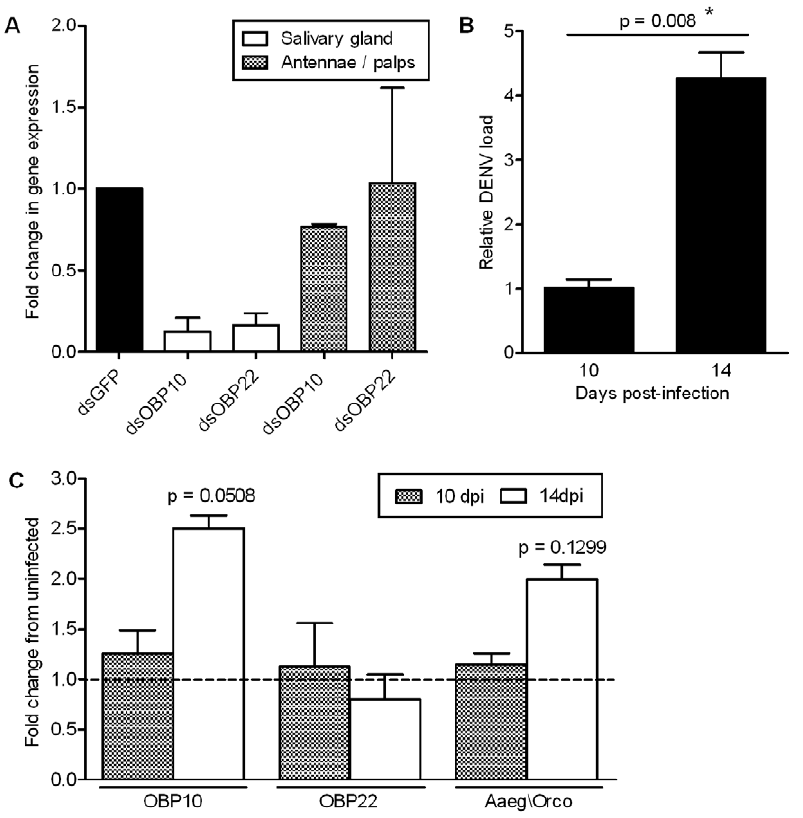
Figure 4. OBP silencing efficiency and gene expression in the chemosensory organs; detection of DENV by RT-PCR in the chemosensory organs. ( A ) Silencing efficiencies for OBPs 10 and 22 in the salivary gland and chemosensory organs (antennae and palps) 4 days post-injection of 2 ug dsRNA, relative to dsGFP-injected controls. ( B ) Detection of DENV by RT-PCR in the antennae and palps of DENV-infected mosquitoes at 10 and 14 dpbm. *, p , 0.05 in Student’s t-test. ( C ) OBP and Aaeg\Orco gene expression in the antennae and palps of DENV-infected mosquitoes at 10 and 14 dpbm, relative to mock-infected mosquitoes. p values were determined with the Student’s t-test.